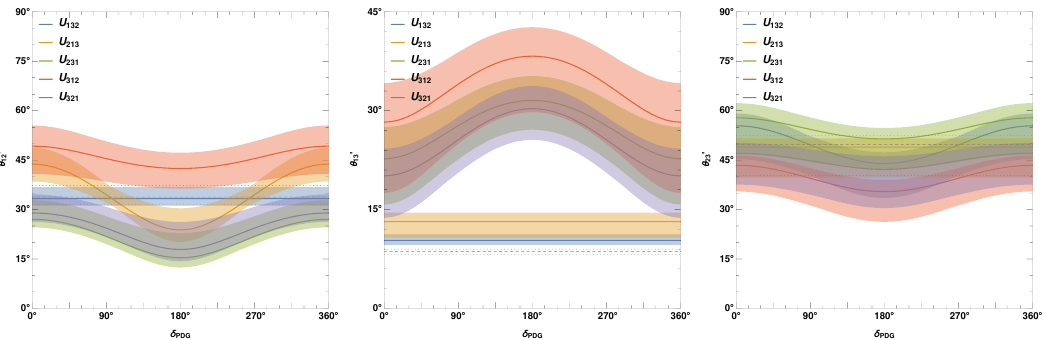
Figure 2 . Mixing angles in each parameterization as a function of δ PDG . The shaded regions show the range of variations of the curves over the 3 σ range of mixing angles from [60] while the dashed (dotted) gray lines are best fit values (maxima and minima of 3 σ ranges) in the standard parameterization.